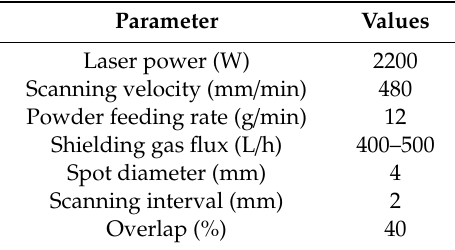
Table 3. Processing parameters of laser melt deposition